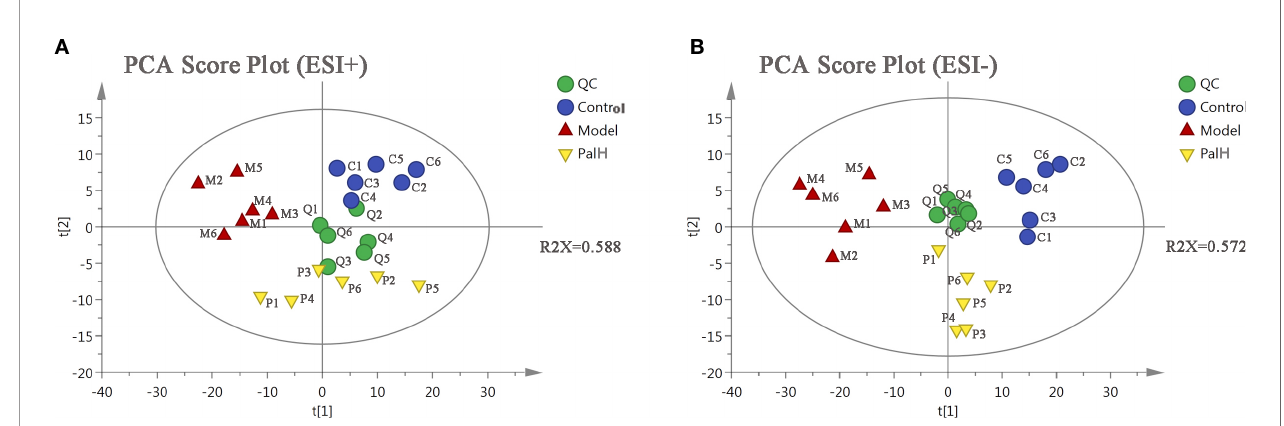
FIGURE 6 | The principal component analysis (PCA) score plot of serum metabolomics analysis. (A) ESI+ model. (B) ESI- model. PalH: (40